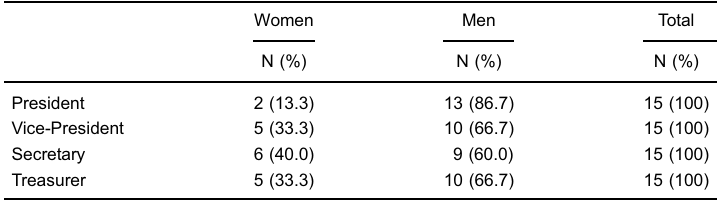
Figure 1. Directory boards of the Brazilian Society of Neu- roscience and Behavior (SBNeC). The four posts (y-axis) are: president, vice-president, secretary, and treasurer. The asterisk indicates the two mandates in which a woman was the President of the Society. Table 2. Directory boards composition by gender and posts summing up the 15 mandates (1978 to 2020) of the Brazilian Society of Neuroscience and Behavior